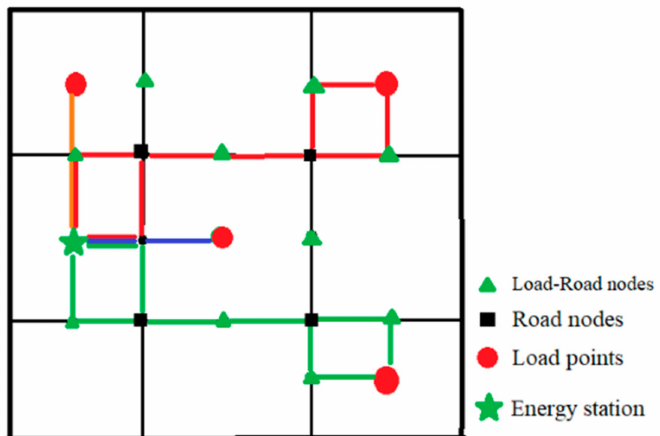
Figure 7. A schematic of connection graph G by Energy Station-to-Load Points